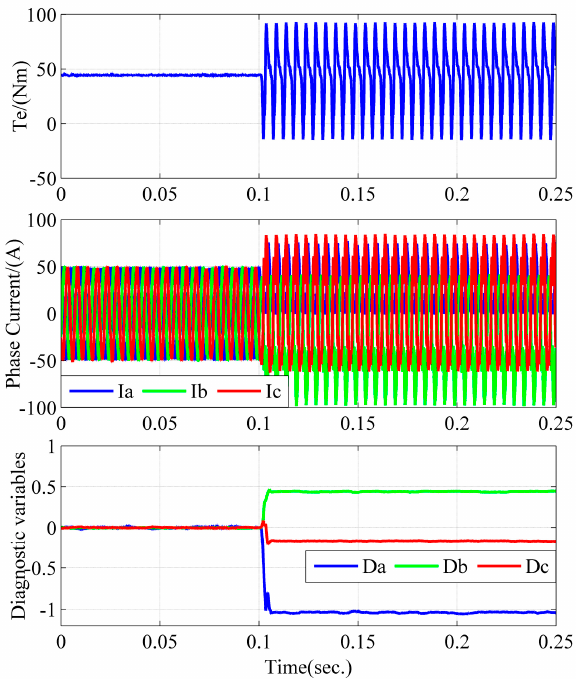
Figure 9. Diagnostic results at 2000 rpm/36 Nm.